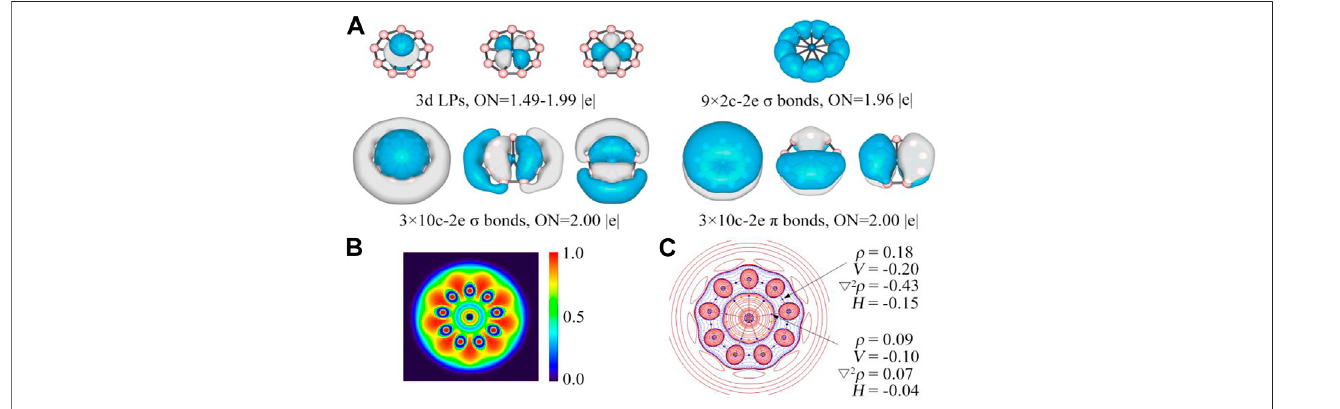
FIGURE3|(A) AdNDPresults,and (B) color- fi lledmapofELFand (C) contourplotofLaplacianofelectrondensityofOsB 9 − .Inc,thecontourlinemapofLaplacian of electron density, red solid lines and blue dotted lines represent positive and negative regions, respectively. Blue and orange points correspond to position of bond criticalpoints(BCPs)andringcriticalpoint(RCP),respectively.ValuesofsomerealspacefunctionsattheBCParegiven,including ρ (electrondensity), V (potentialenergy density), ∇ 2 ρ , H (energy